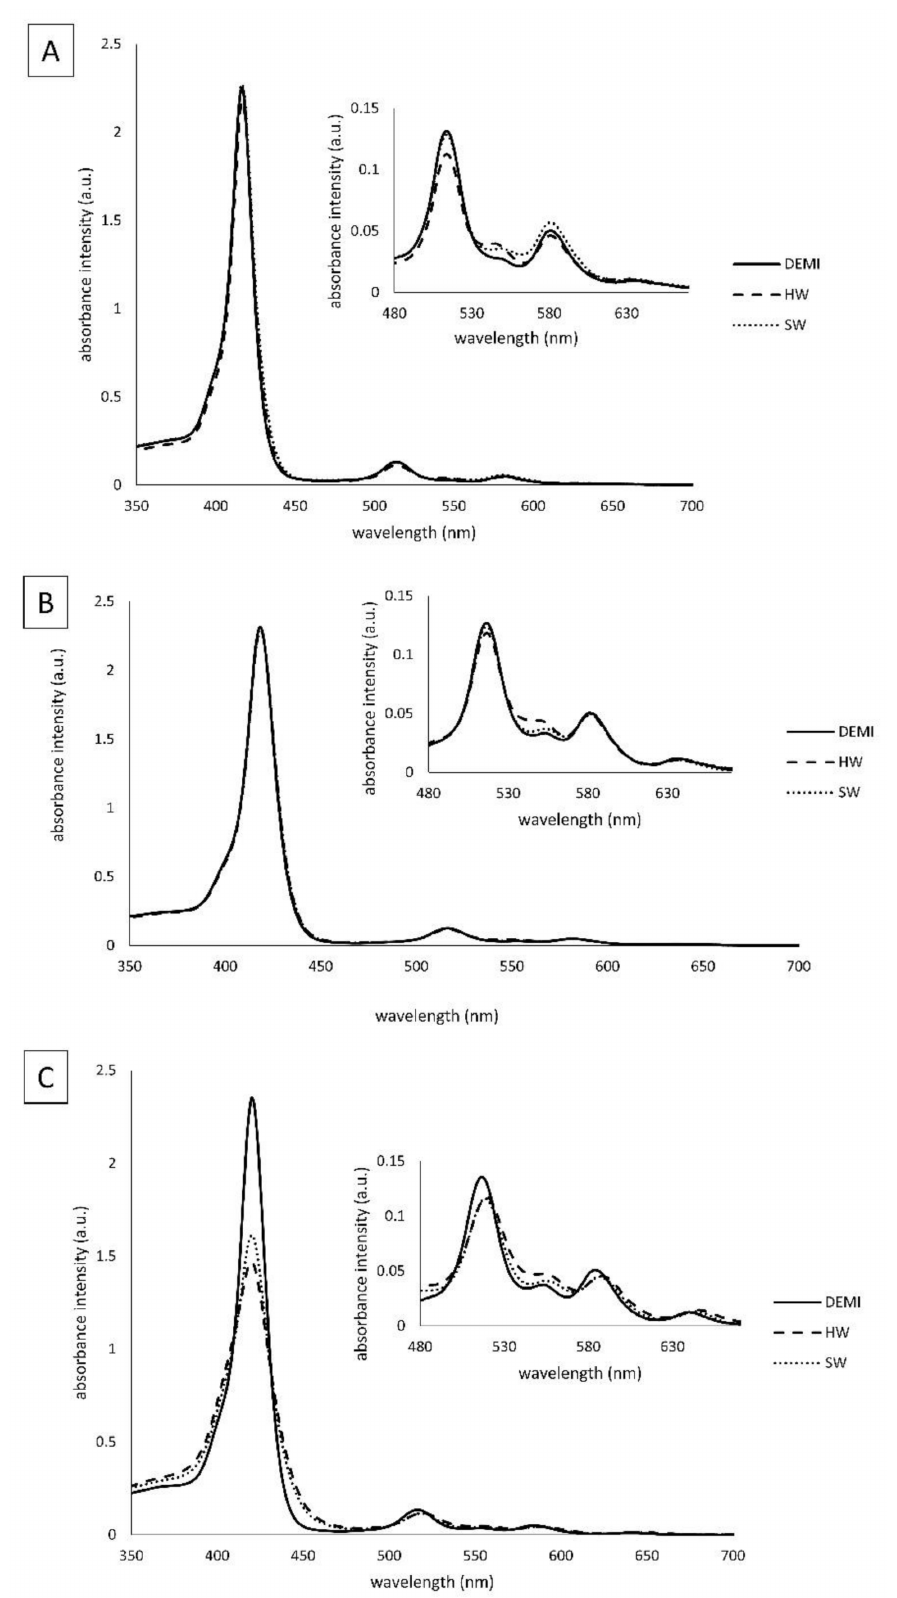
Figure 2. Absorption spectral characteristics of TMPyP3 ( A ), TMPyP3-CH 3 ( B ), and TMPyP3-C 17 H 35 ( C ) in DEMI (full line), soft water (dashed line), and hard water (dotted line). All measurements were performed in 10 µ M